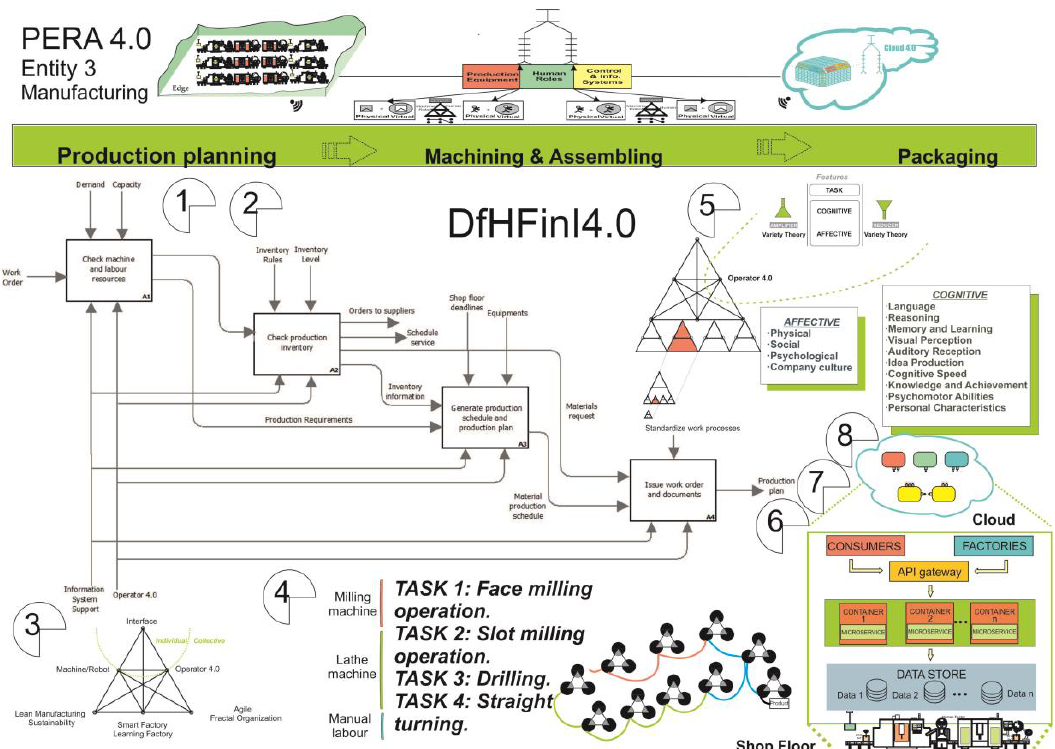
Figure 11. Application of the DfHFinI4.0 framework to the design and development process of entity three of PERA in the manufacturing system.